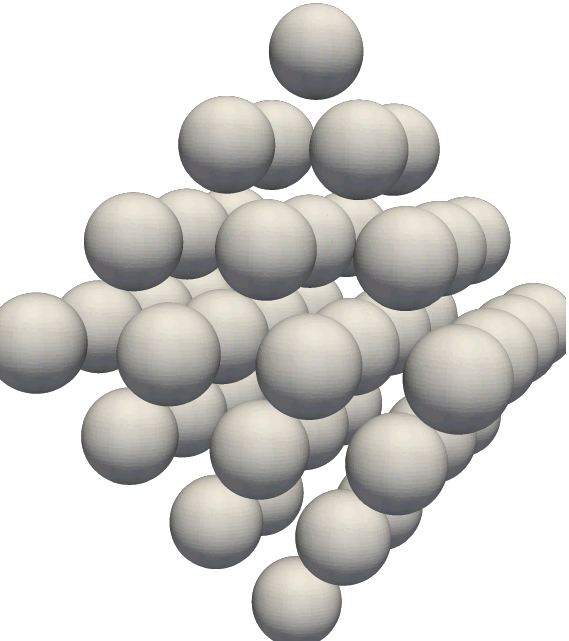
Figure 1. Synthetic rhomboid-shaped particle cluster with a void fraction ( φ ) of 0.741 (120 µ m distance between particle centers).